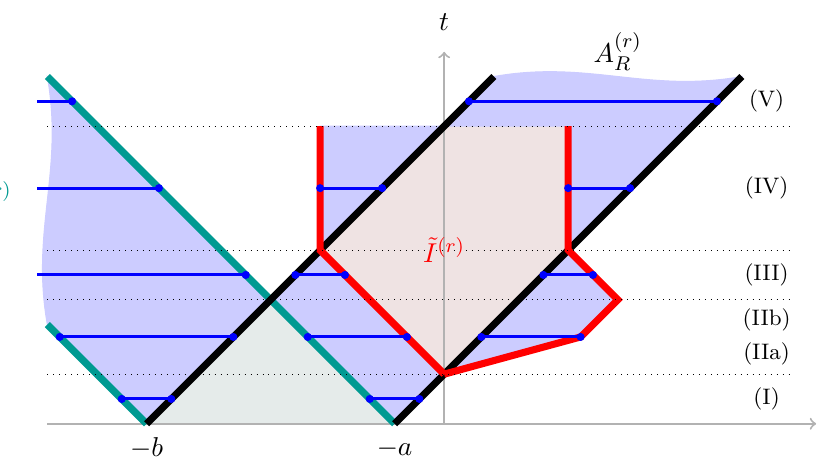
Figure 17 . The 3 subsets A ( r ) (black), ˜ A ( r ) (green) and ˜ I ( r ) (red) on I + as a function of time. R L R Given that the latter two purify the former, the net contribution to the entropy at any given time is given by A ( r ) (cid:9) ( ˜ A ( r ) ∪ ˜ I ( r ) ) the blue area (plus the contribution from the QES). Example time R L slices are shown in each time regime. In regime (III), the blue regions are shrinking due a collision between ˜ A ( r ) and the island in the stream ˜ I ( r ) as t increases accounting for the dip in the L